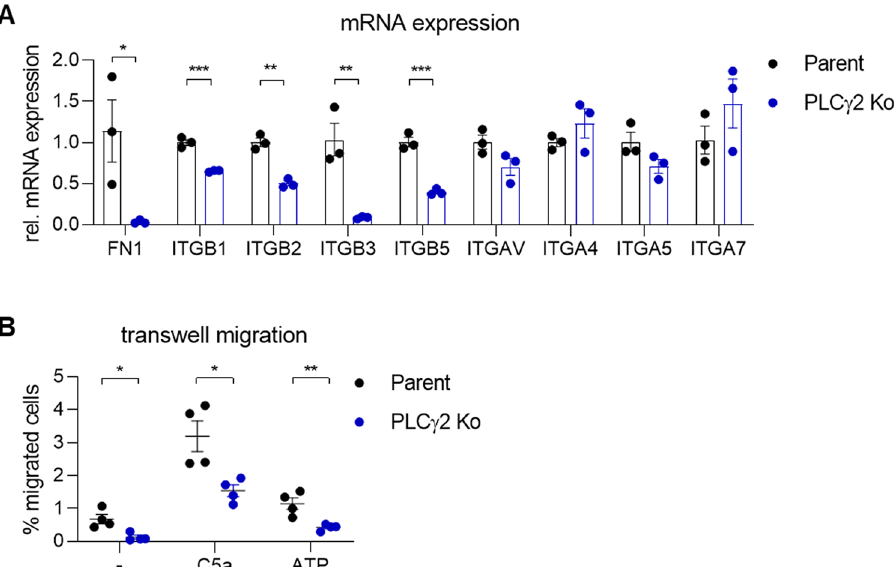
Figure 6. Dysregulation of integrin subunits and deficits in migratory behaviour in PLCγ2 Ko macrophages. ( A ) RT-PCR analysis shows a reduction of fibronectin (FN1) and several β-subunits in PLCγ2 Ko cells. n = 3, ( B ) Migration without chemotactic cue and directed migration towards C5a (3 nM) and ATP (1 mM) are reduced in PLCγ2 Ko cells, n = 4. Data shown represent mean ± SEM, Multiple Student’s t-tests. * p < 0.05, ** p < 0.01, *** p <